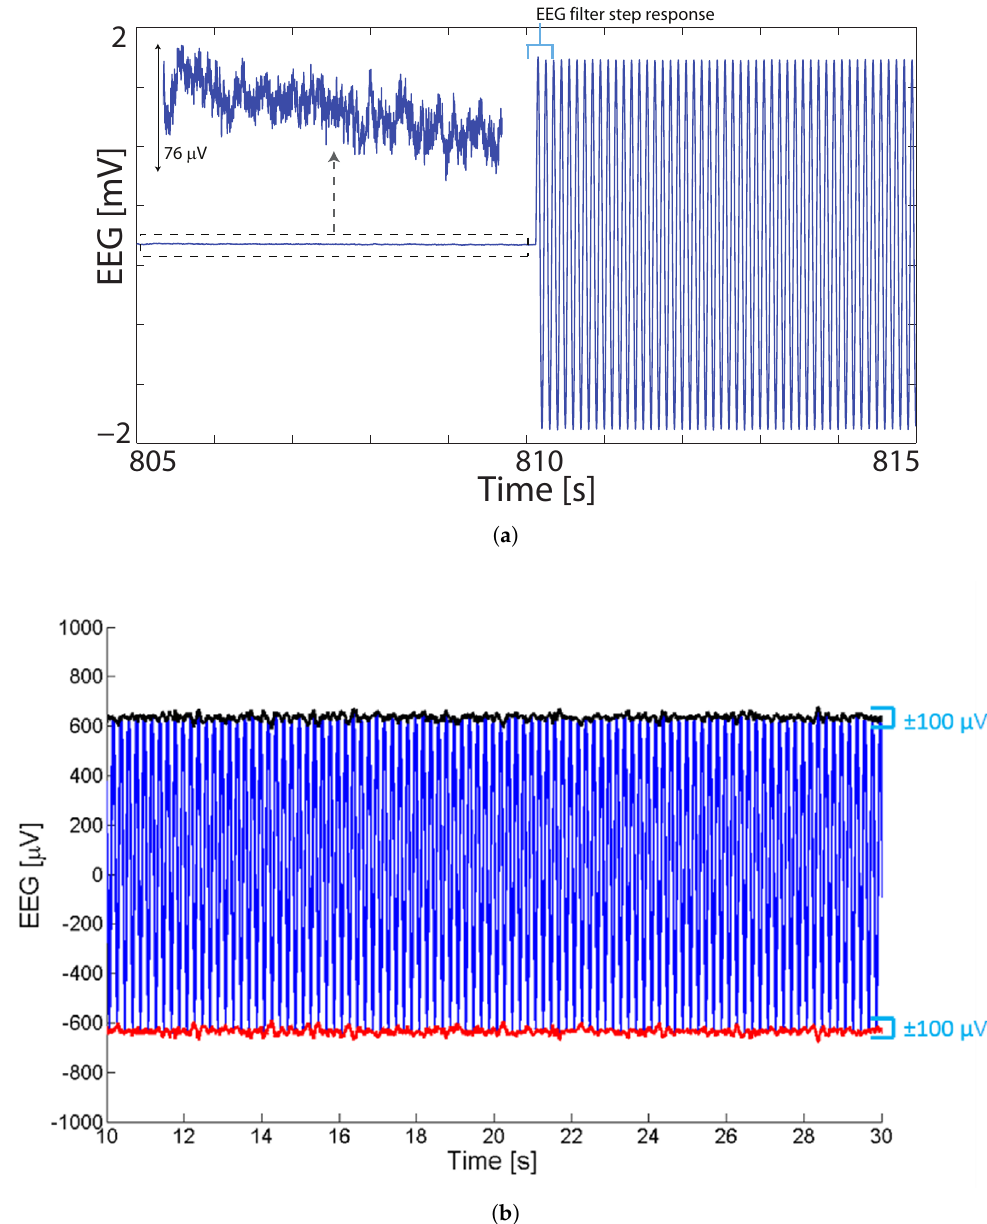
Figure 2. EEG data recorded during tACS stimulation. ( a ) Stimulation begins at 810 s at which point all recorded data are dominated by a large sinusoidal artifact. Figure originally reported in [12] (with copyright permission from IEEE). ( b ) Raw collected EEG+tACS data with no band limiting filters applied. Ongoing artifact is not a pure sinusoid at the simulation frequency, but has an approximately 100 µ V ripple